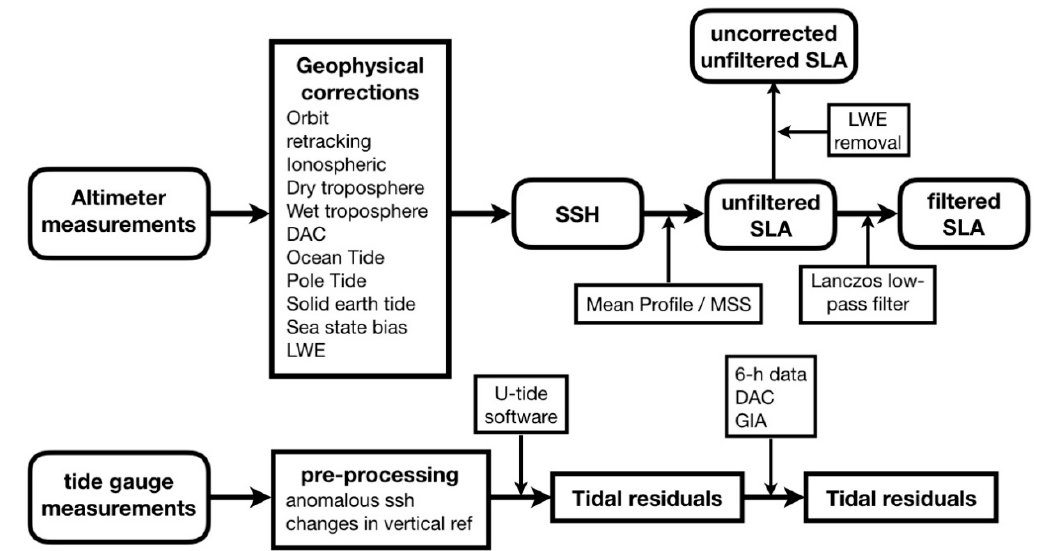
Figure 1. Flowchart of the Data Unification and Altimeter Combination System (DUACS) procedure applied to altimetry data and the processing of the tide gauge data used to compare with altimetry.